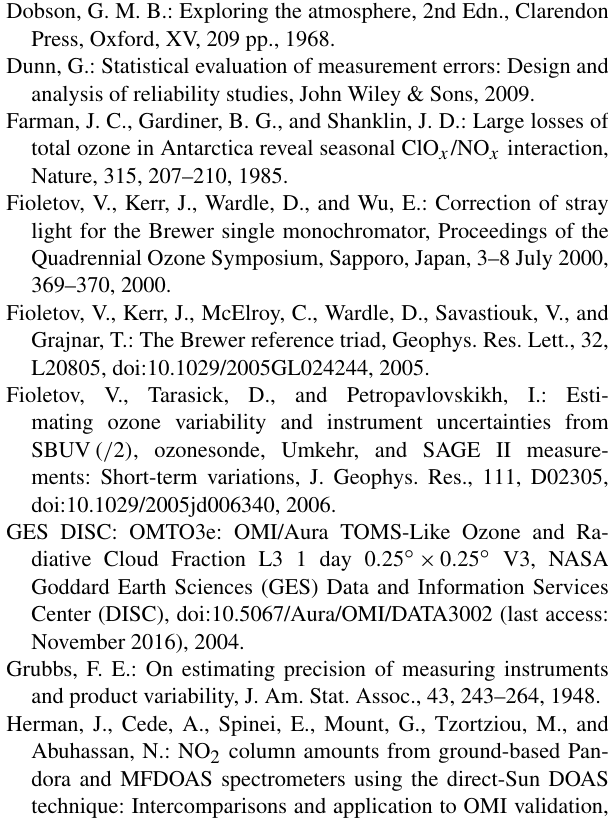
algorithm theoretical baseline document: OMI ozone